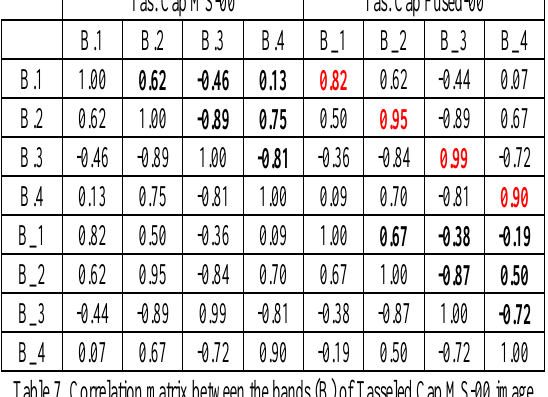
Table 7. Correlation matrix between the bands (B) of Tasseled Cap MS-00 image